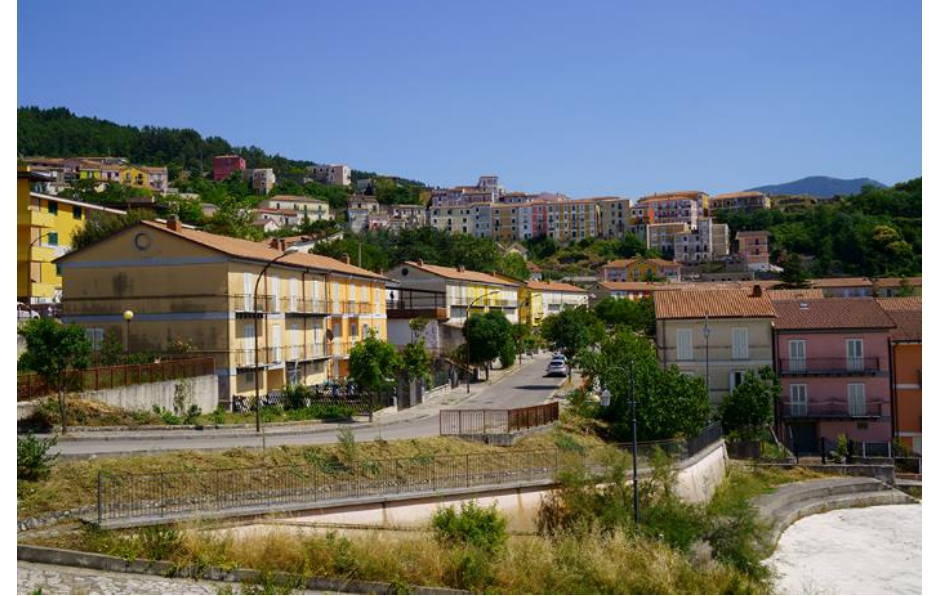
Figure 5. Castelnuovo di Conza: overview of the new village completely rebuilt after the1980 earthquake (photos by [35,36]).